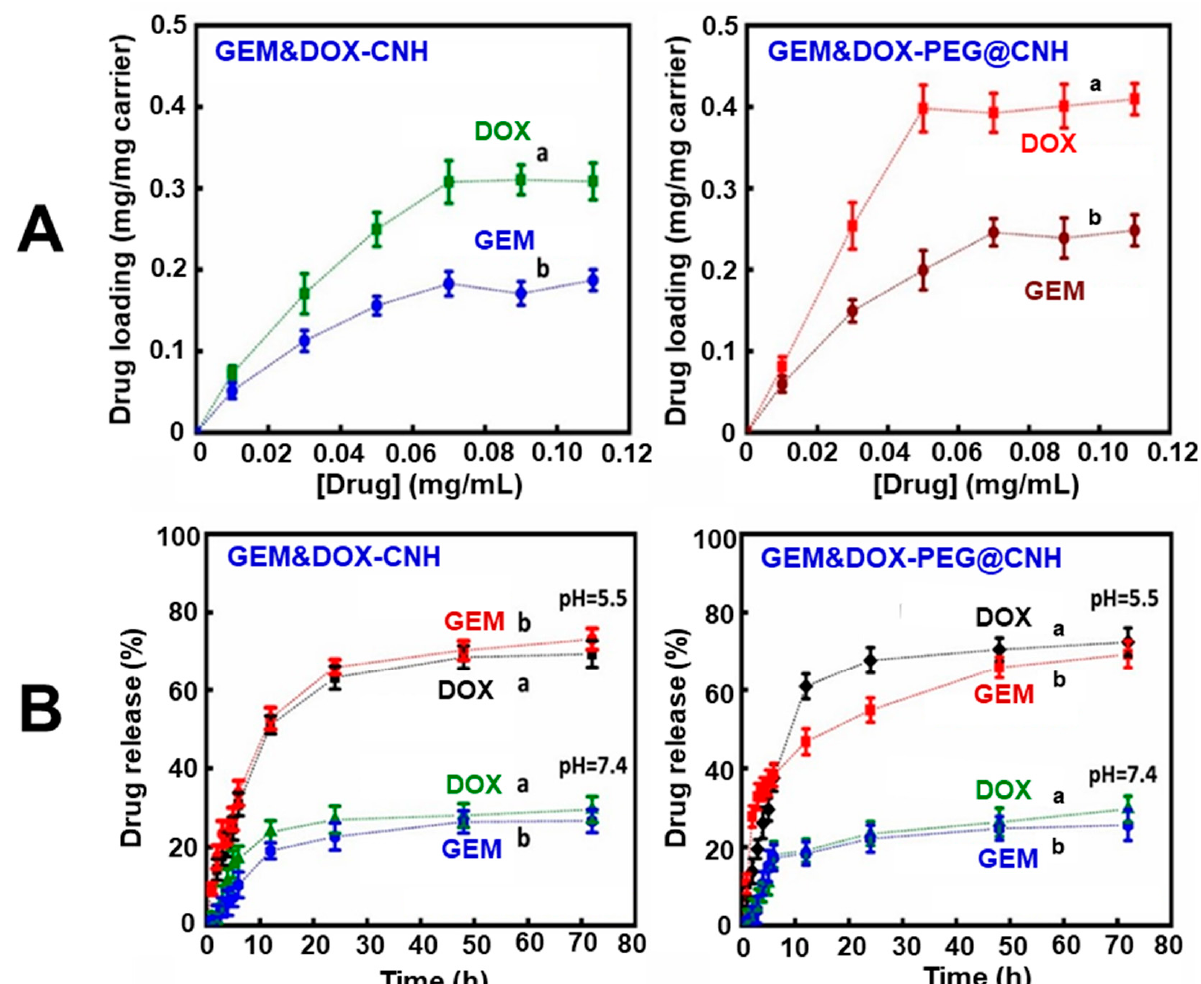
Figure 6. ( A ) Drug co-loading and ( B ) co-release at pH 5.5 and 7.4 of (a) DOX and (b) GEM on CNH and PEG@CNH.